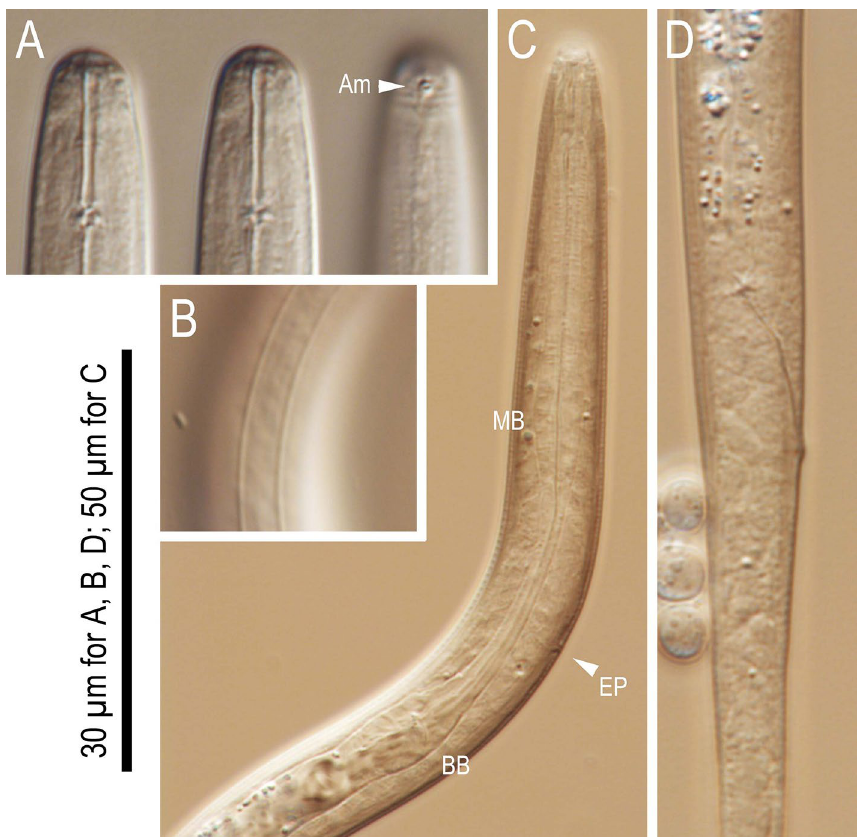
Figure 6. Dauer juvenile of Tokorhabditis tufae n. gen., n. sp. ( A ) Lip region in three different focal planes; ( B ) Body surface showing lateral field; ( C ) Right lateral view of anterior region; ( D ) Right lateral view of tail region. Sheath of the dauer was removed manually for